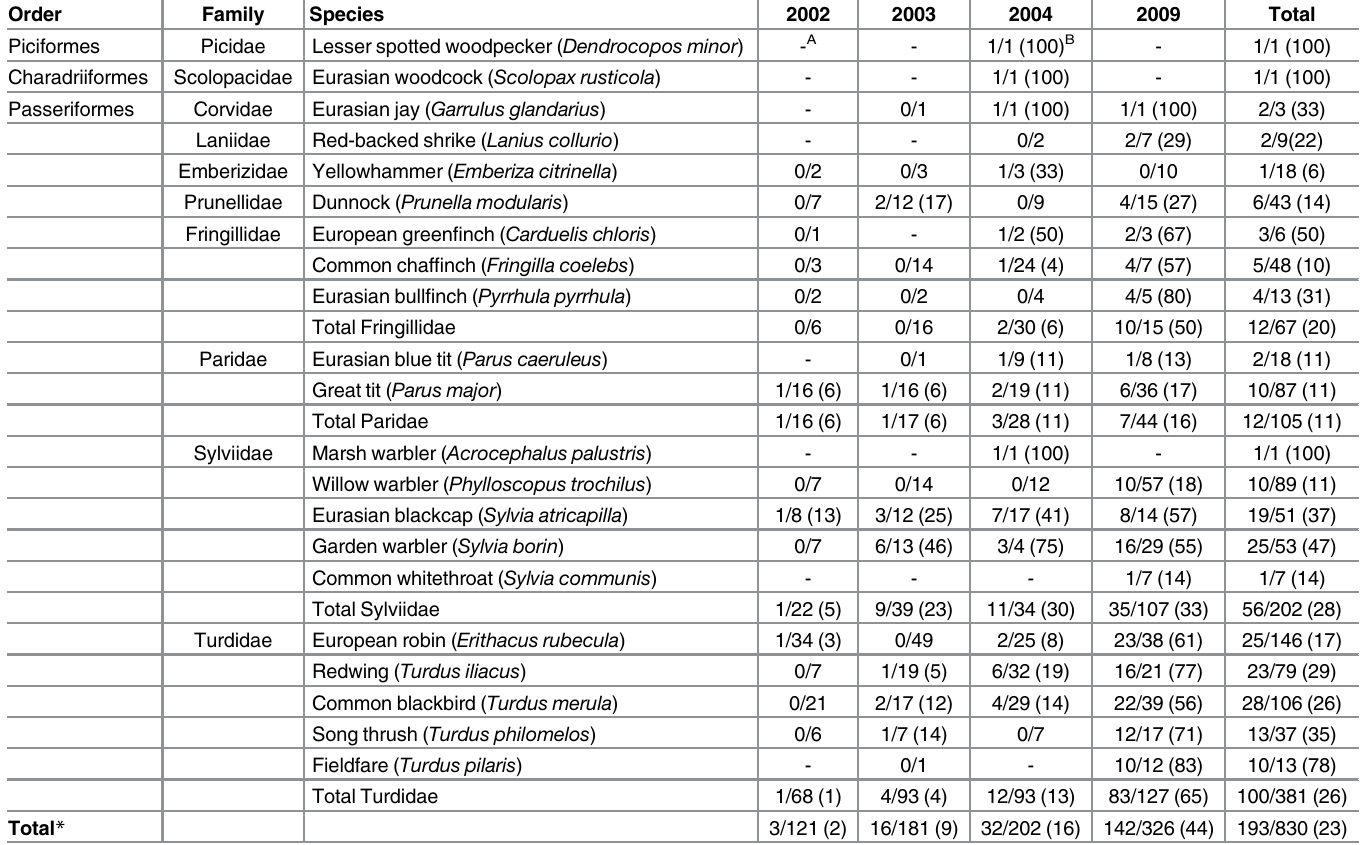
included in the table for clarity. These are (alphabetically ordered): 1 Barred warbler ( Sylvia nisoria ), 1 Common grasshopper warbler ( Locustella naevia ),